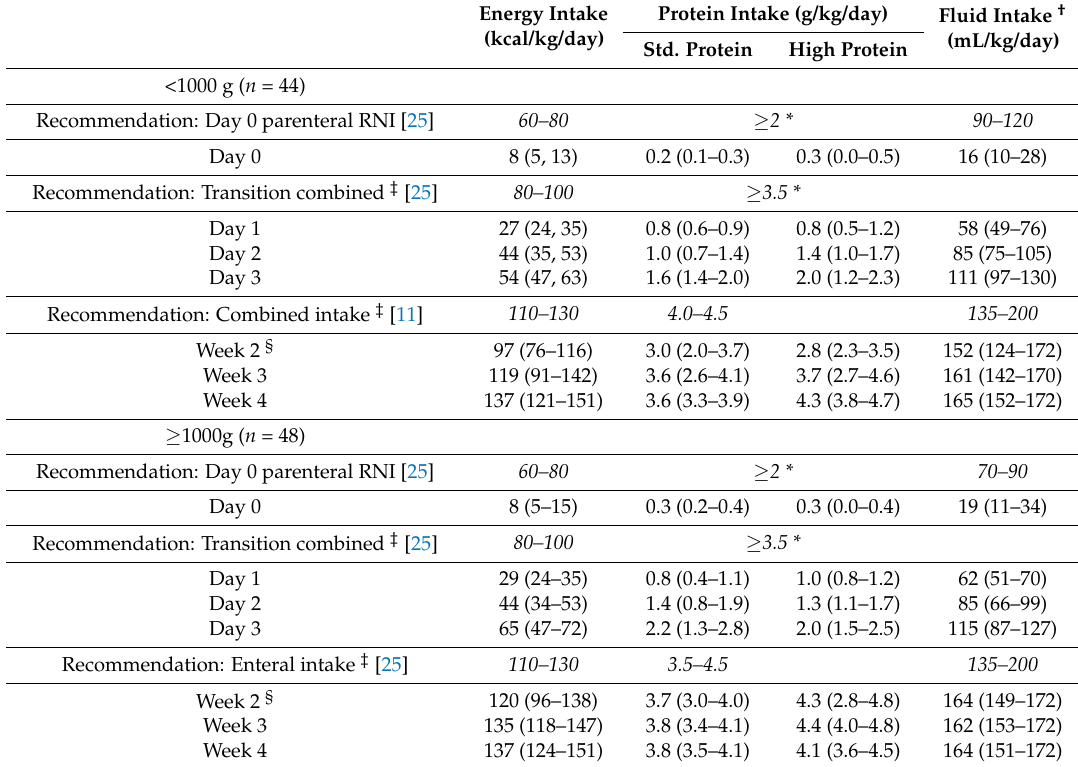
Table 3. Days 0–3 and weekly intakes of energy, protein and fluid compared with